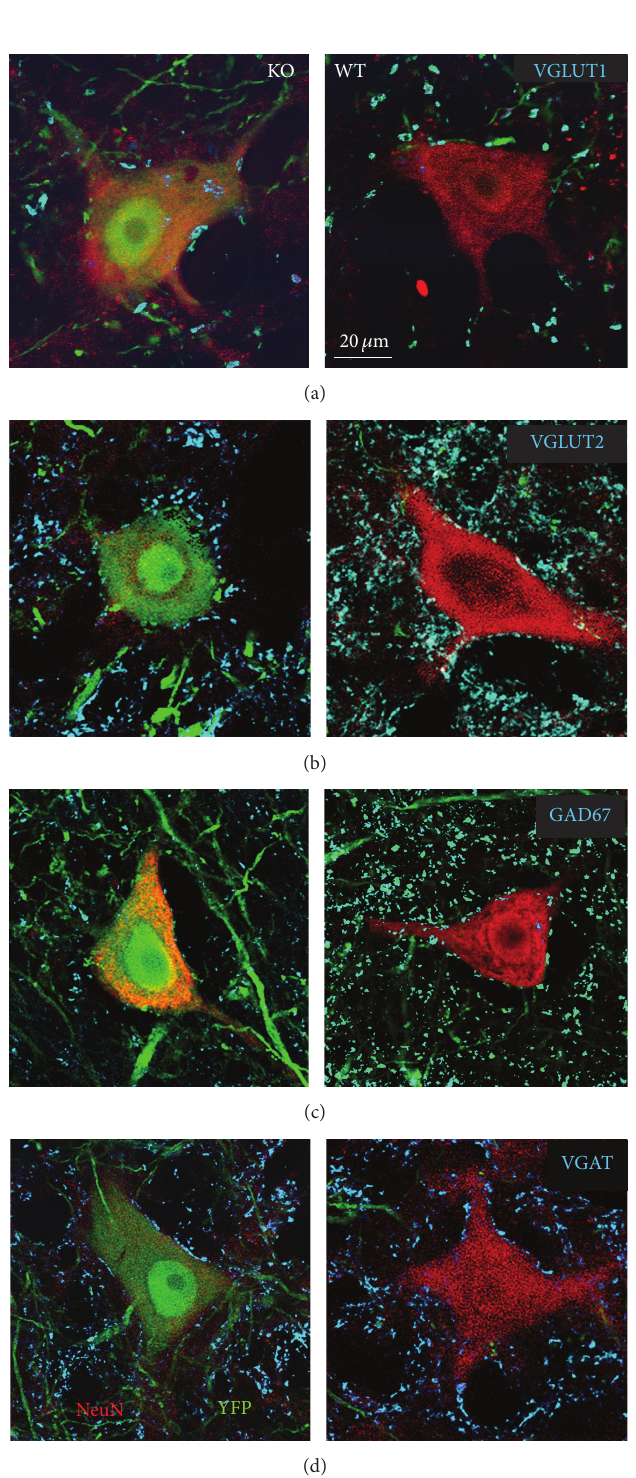
Figure 1: Immunoreactivity to different synapse-associated antigens surrounding the somata and proximal-most dendrites of large neurons in lamina IX of the L3–5 segments of the spinal cord of SLICK::trkB mice that had been treated with tamoxifen to knock out the trkB gene is shown. Cells expressing YPF (left column) are presumed to be null for the trkB gene and cells in the same histological sections that are YFP − are presumed to have normal expression of this gene. NeuN immunoreactivity (red) is shown to identify these cells as neurons. Because of their large size and laminar location they were considered motoneurons. Synaptic structures immediately adjacent to the perimeters of these cells (cyan) represent contacts made by structures immunoreactive to VGLUT1 (a), VGLUT2 (b), GAD67 (c), or VGAT (d). All cells are shown at the same